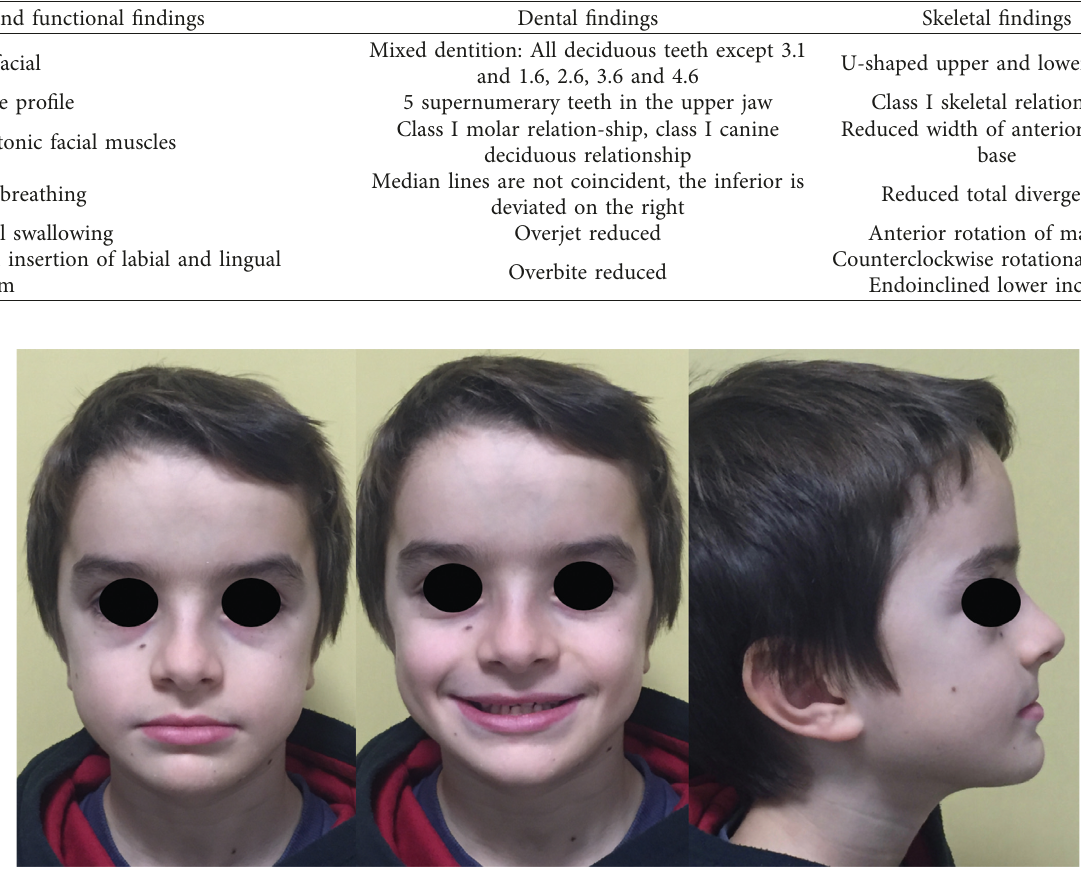
Table 11: Case 1: orthodontic diagnosis summary.